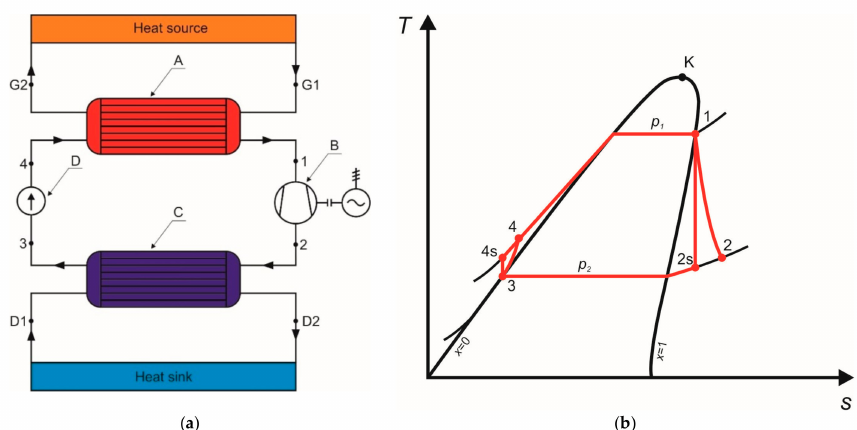
Figure 1. A scheme and thermodynamic cycle of the simple organic Rankine cycle (ORC) system. ( a ) Scheme of the ORC system; ( b ) Organic Rankine cycle visualized in T - s